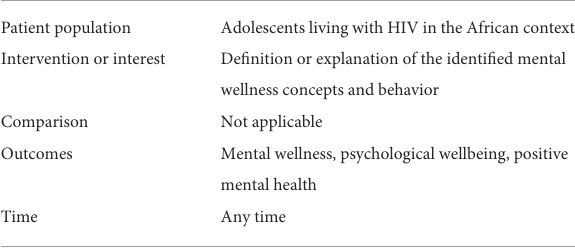
TABLE 1 PICOT based inclusion criteria for literature